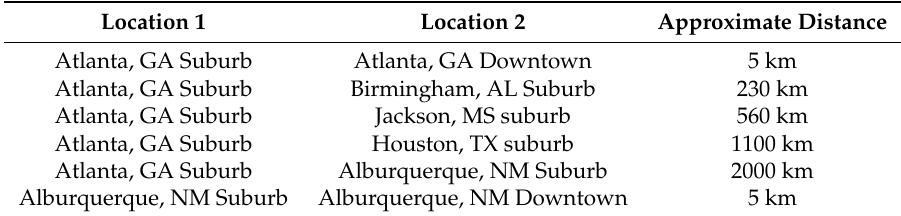
Table 2. Locations used to examine